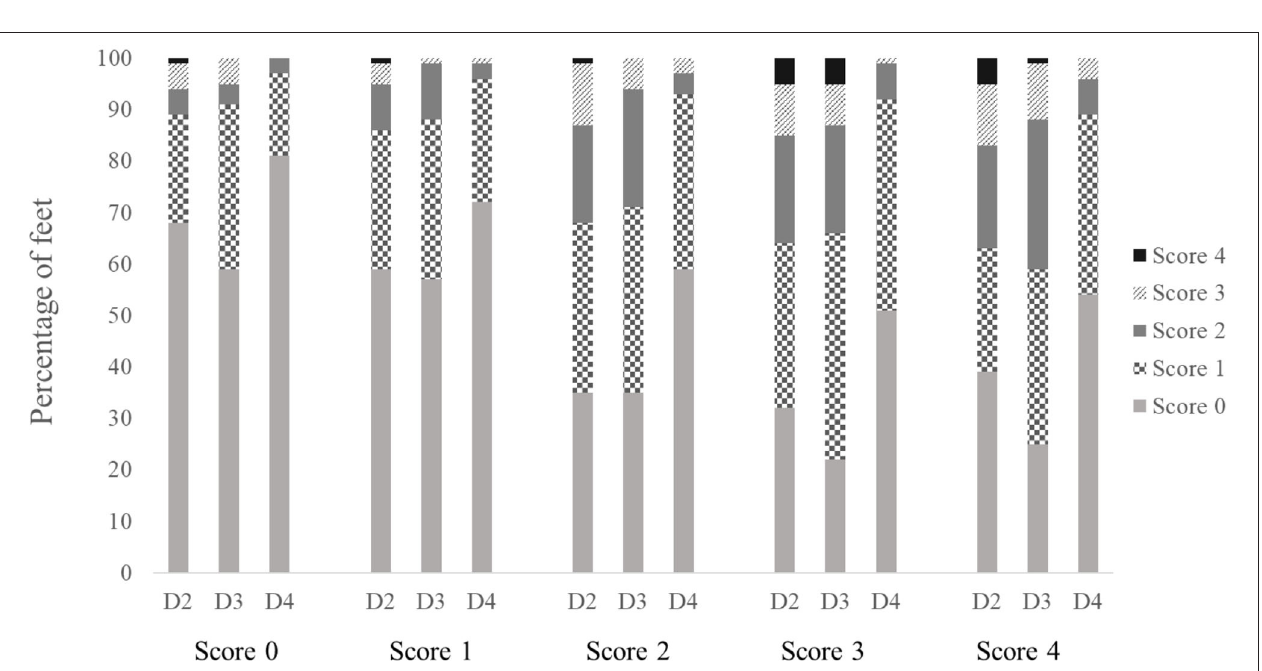
FIGURE 2 | Number of affected digits for the different scoring levels of the standard FPD scoring system of the metatarsal pad (score 0 = intact foot; score 1 = alterations ≤ 10%; score 2 = alterations ≤ 25%; score 3 = alterations ≤ 50% and score 4 = alterations > 50%). Data are presented as percentage, n = 500 feet.